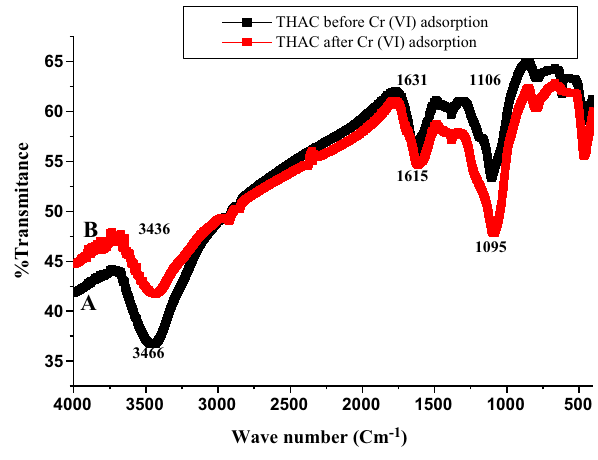
Fig. 1 FT-IR spectra of THAC in KBr disk; a before Cr(VI) adsorp- tion and b after Cr(VI)